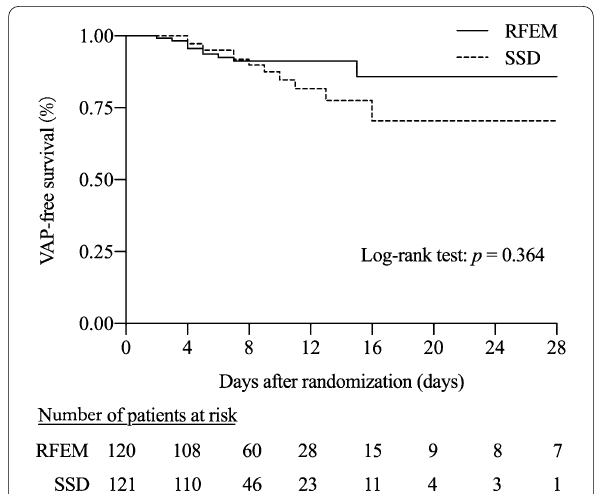
Fig. 2 Kaplan–Meier curves of cumulative rates of patients remaining free of ventilator‑associated pneumonia in two